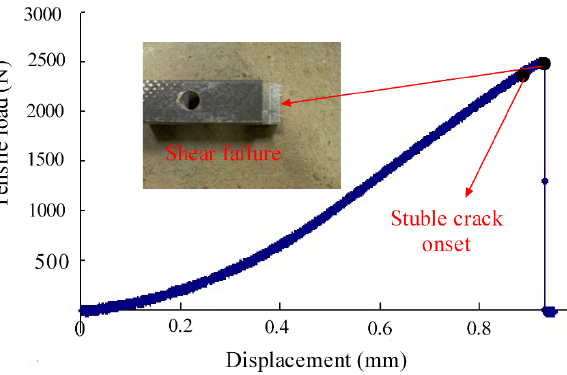
Table 3: Interlaminar shear stresses under different external